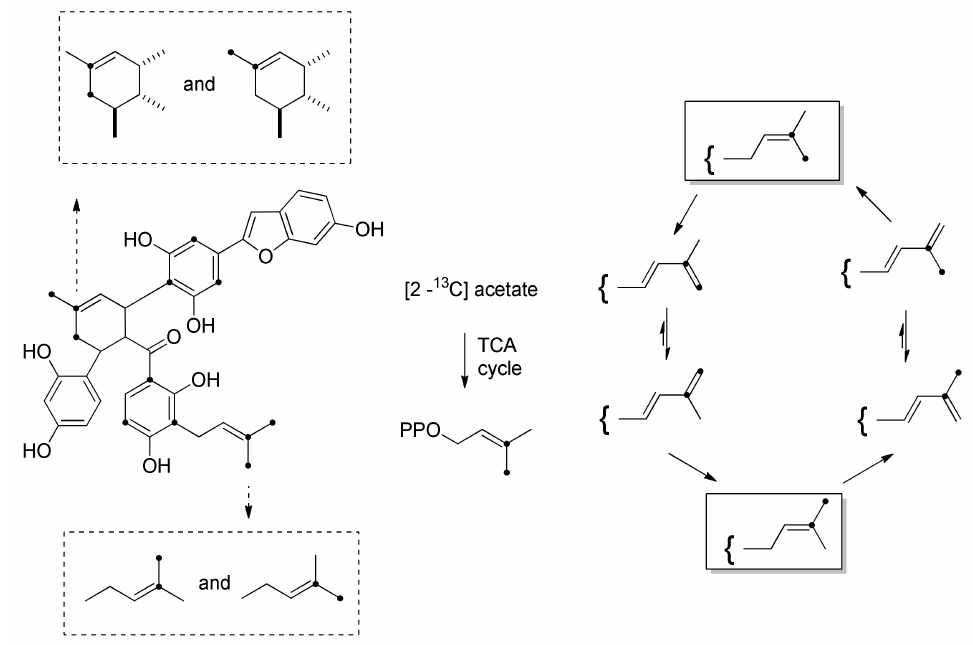
Figure 11. Pulsed administration experiment with [2- 13 C] acetate revealing the polyketide moieties and the oxidation of the prenyl group to the dehydroprenyl